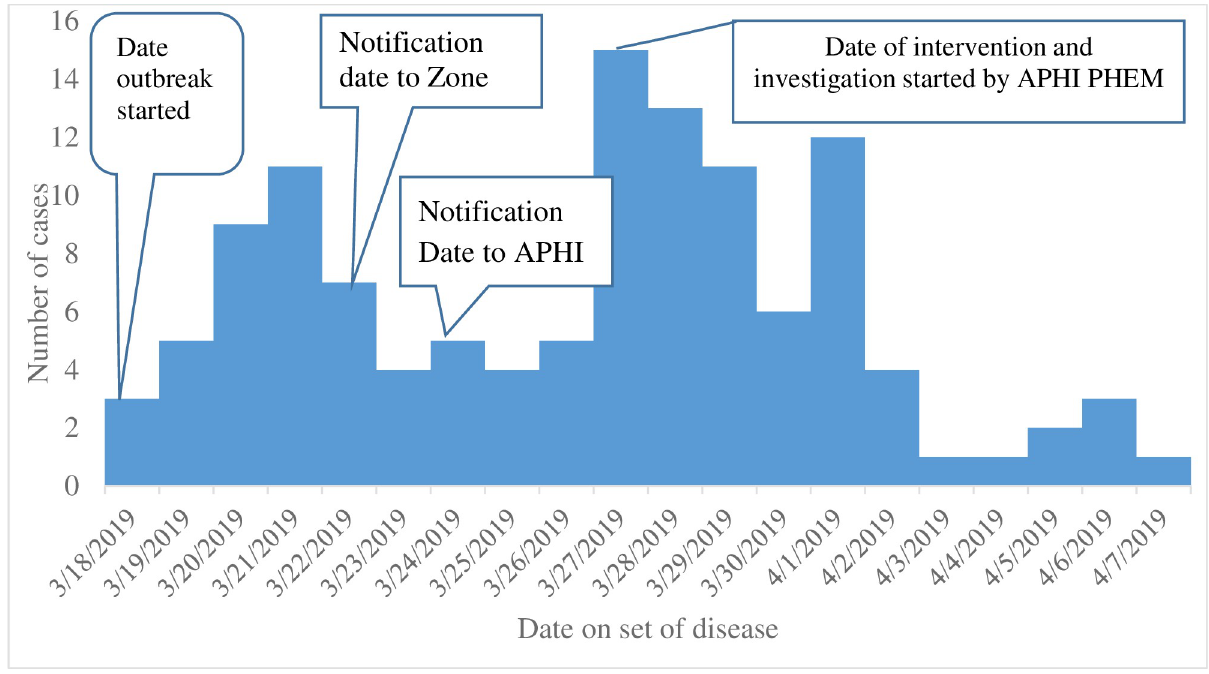
Fig 2. EPI curve of the pertussis outbreak over time in Gomengie and Seramre Kebele, April 2019. APHI = Amhara Public Health Institute.